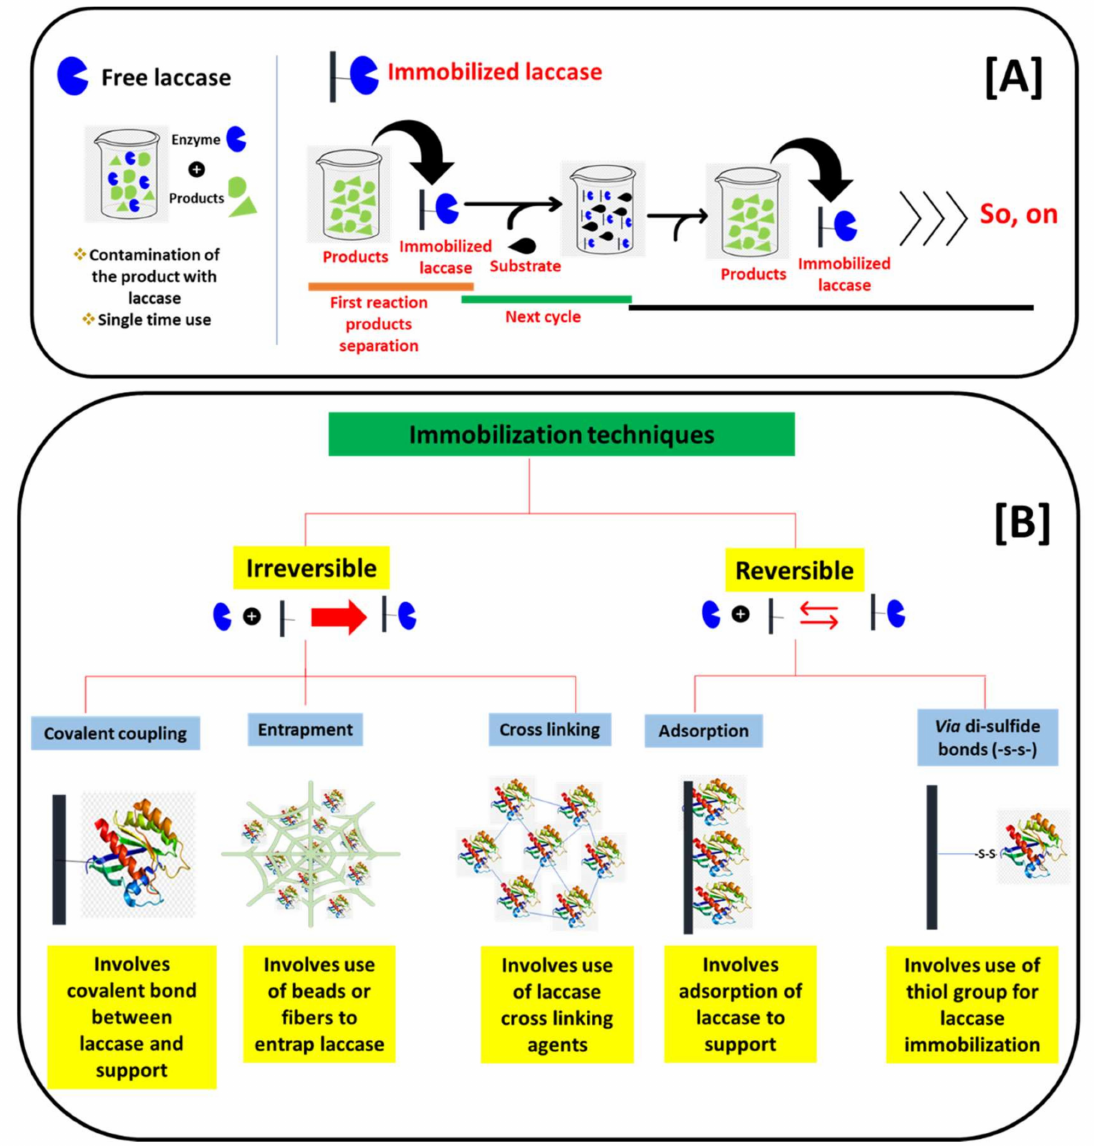
Figure 4. Schematic presentation of the ( A ) basic difference between free and immobilized laccase- catalyzed reactions, and the ( B ) differentiation of laccase immobilization techniques based on a binding pattern with a support